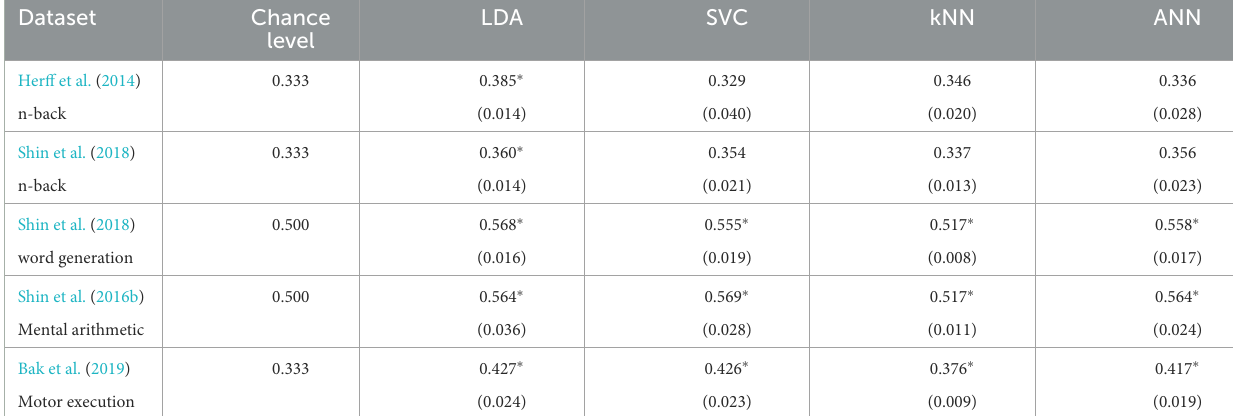
TABLE 4 Accuracies of the models on each dataset with the generalised approach using a 2 s sliding time window.